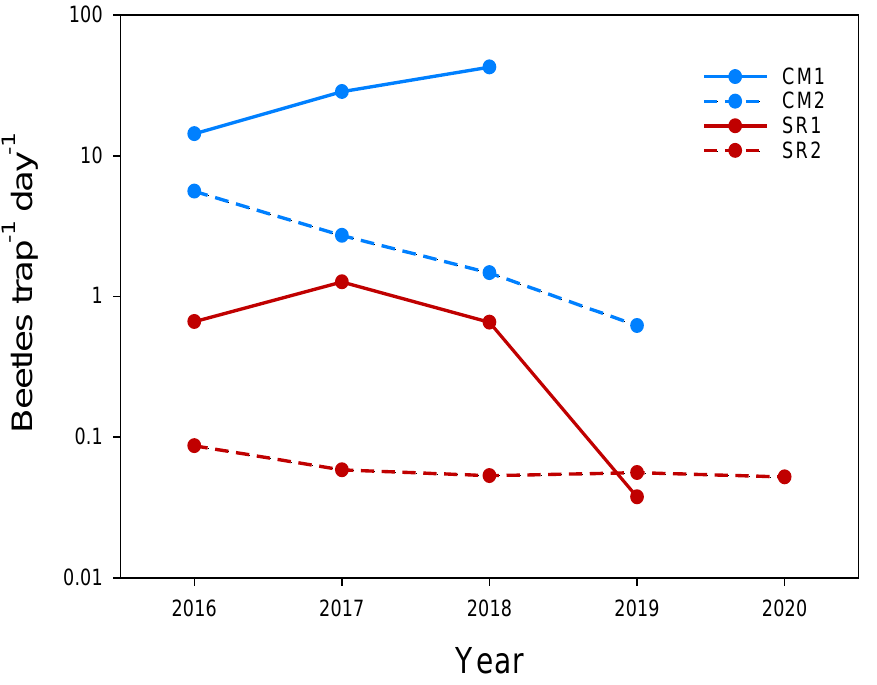
Figure 2. Effects of structural rotation (winter wheat/maize/soybean) on WCR population levels over the years. Numbers of WCR adults/trap/day (total sum at six weeks) in two different scenarios are shown — the first with a high percentage of continuous maize (blue lines and symbols = CM1, CM2) in Treviso province and the second based on structural rotation (red lines and symbols = SR1, SR2) at Vallevecchia pilot farm in Venice province (2016 – 2020), both in north-eastern Italy. Legend: CM1 = high presence of continuous maize with traps in continuous maize fields (Treviso); CM2 = high presence of continuous maize with traps in rotated maize fields (Treviso); SR1 = extensive structural crop rotation with traps in continuous maize fields (Vallevecchia, Venice); SR2 = extensive structural crop rotation with traps in first-year maize (Vallevecchia, Venice). Numbers are two-point moving averages.